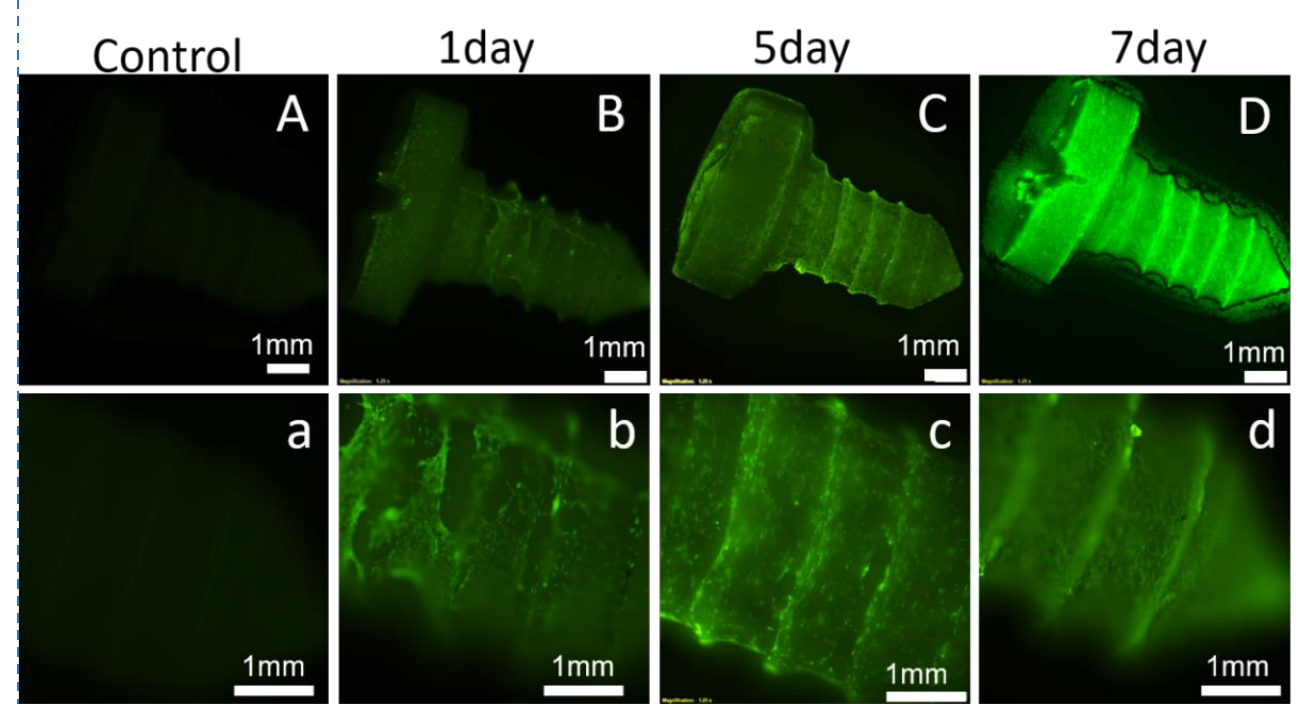
Figure 7. The stereoscopic fluorescence microscope images of hBMSCs growth morphology on the silk screws @10 wt% SNFs at different time points. ( A , a ) represent the silk screw unloaded cells. The cells were stained by a live/dead assay kit. Live/dead staining of hBMSCs cultured on silk screws in growth medium at day 1 ( B , b ), day 5 ( C , c ), and day 7 ( D , d ). Strong green fluorescence without visible red fluorescence demonstrated the cytocompatibility of the silk screws.